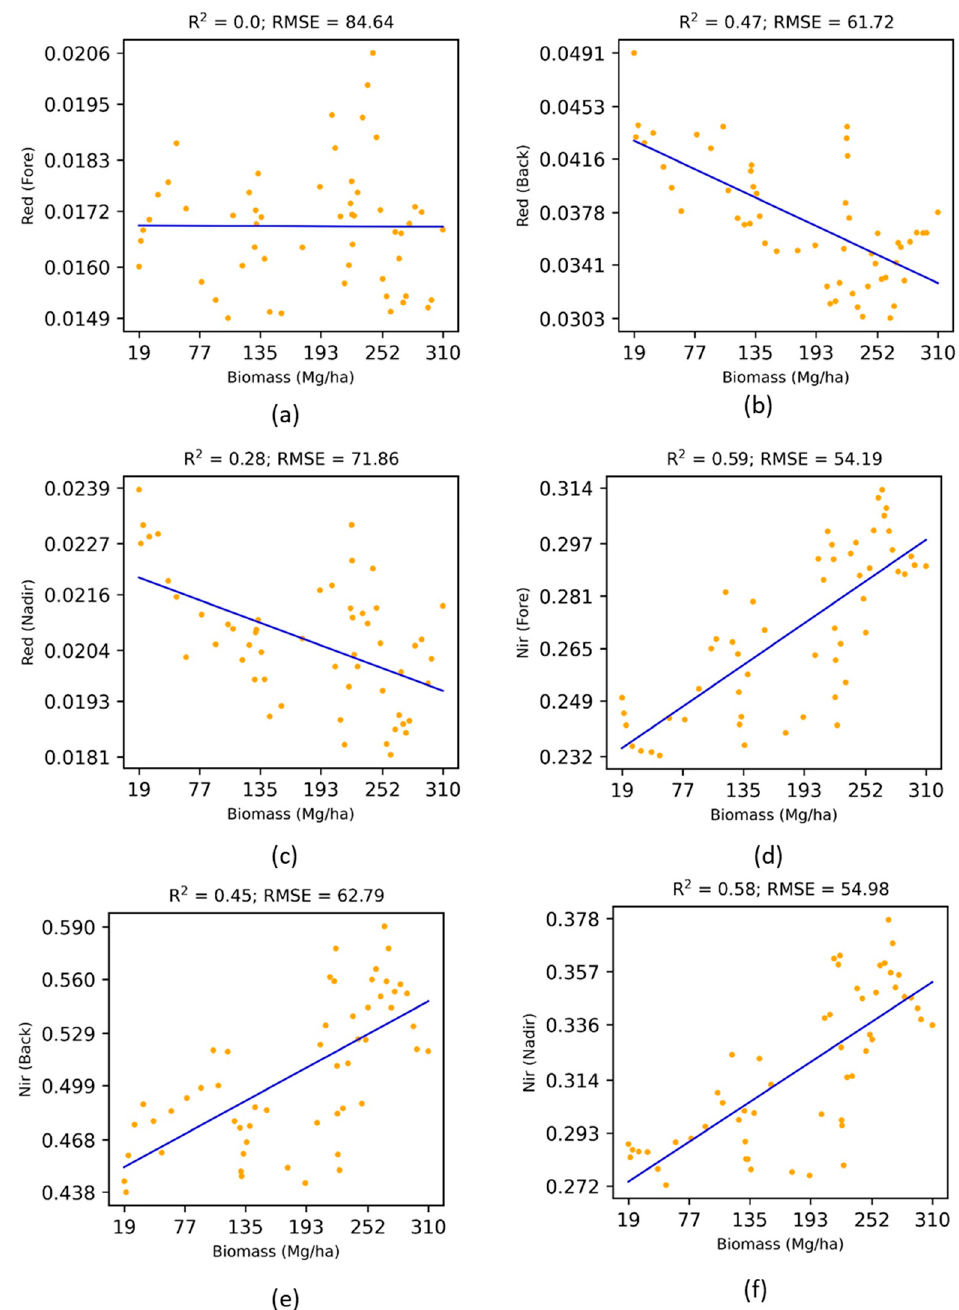
Figure 5. Effects of view angles on the above-ground biomass.